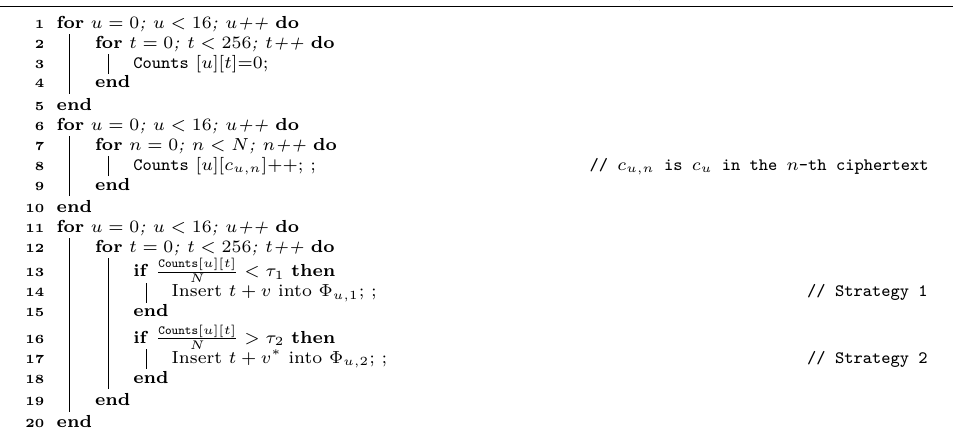
15 P 15 P φ u, 1 , φ 2 ( n ) = φ u, 2 u =0 u =0